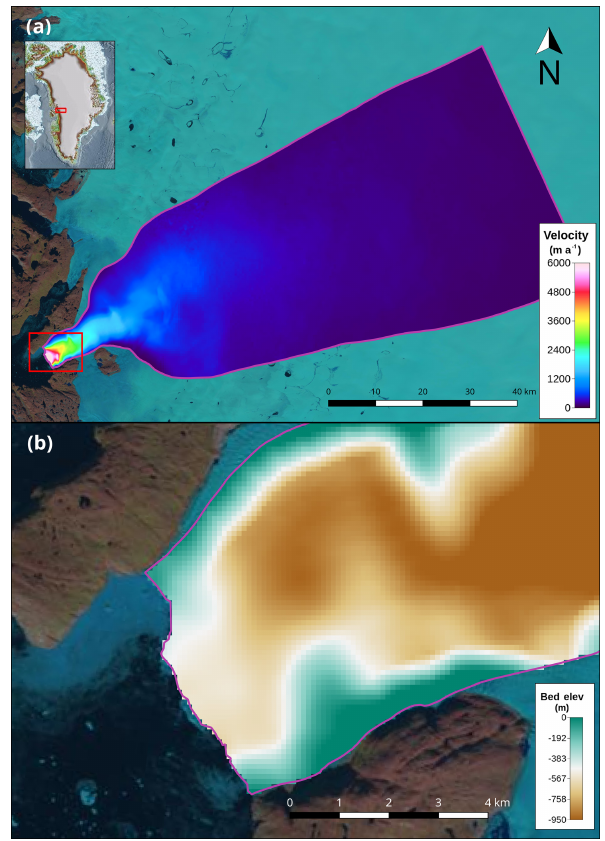
Figure 2. (a) Site map showing MEaSUREs velocity in the mod- elled domain of Store Glacier. (b) Basal topography near the glacier